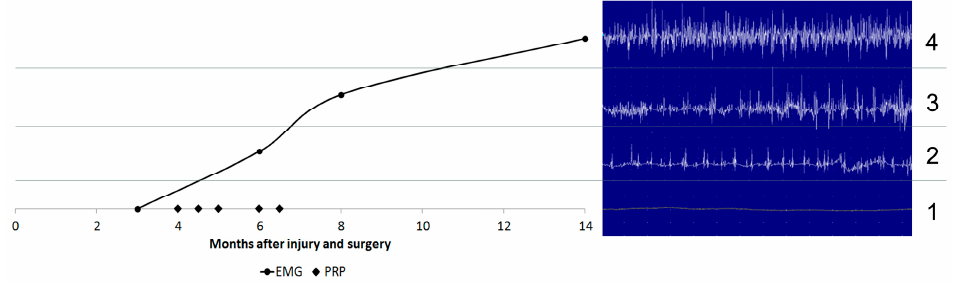
Figure 3. Electromyographic control from surgery up to date. Three months after surgery ( 1 ); sSix months after surgery, three after first PRP injection ( 2 ); eight months after surgery, five after the first PRP injection ( 3 ); and one year after surgery, nine months after first PRP injection ( 4 ). EMG: electromyogram; PRP: platelet-rich plasma infiltrations.